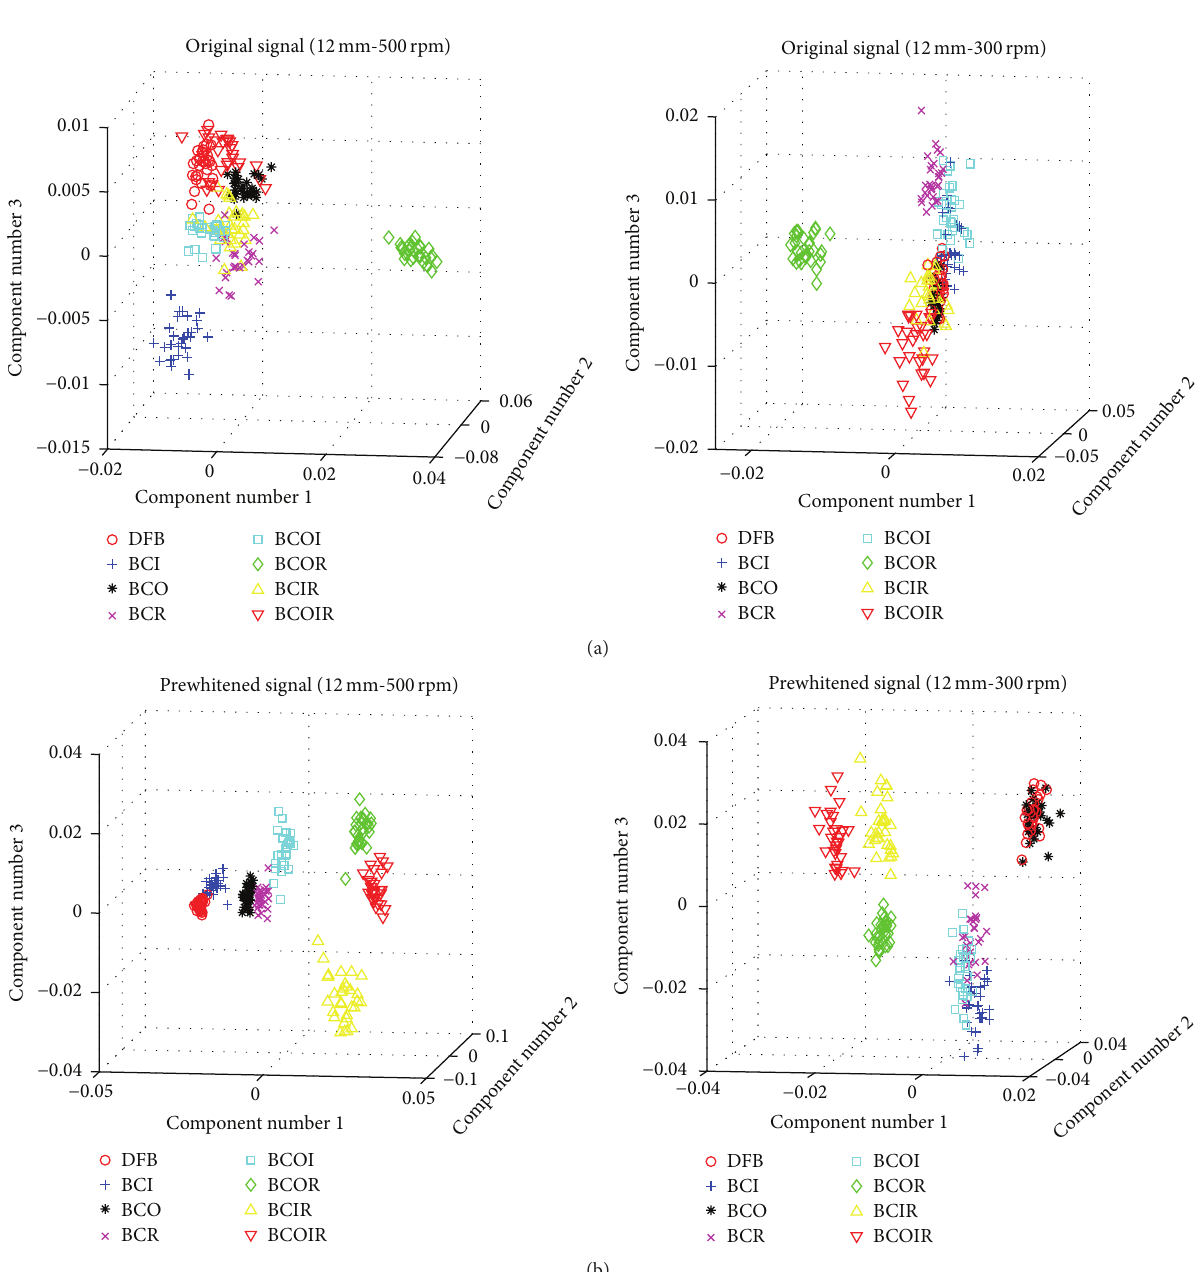
Figure 7: Feature distribution spaces with a bearing crack size of 12 mm. (a) Before prewhitening and (b) after